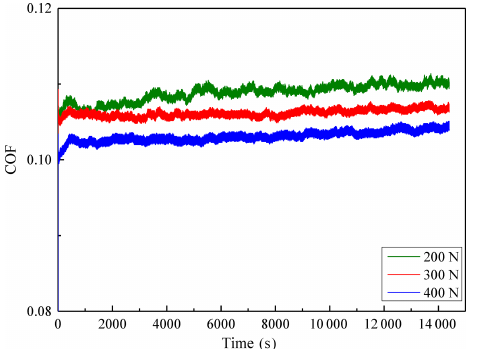
Figure 12. The COF and surface roughness under different loads.